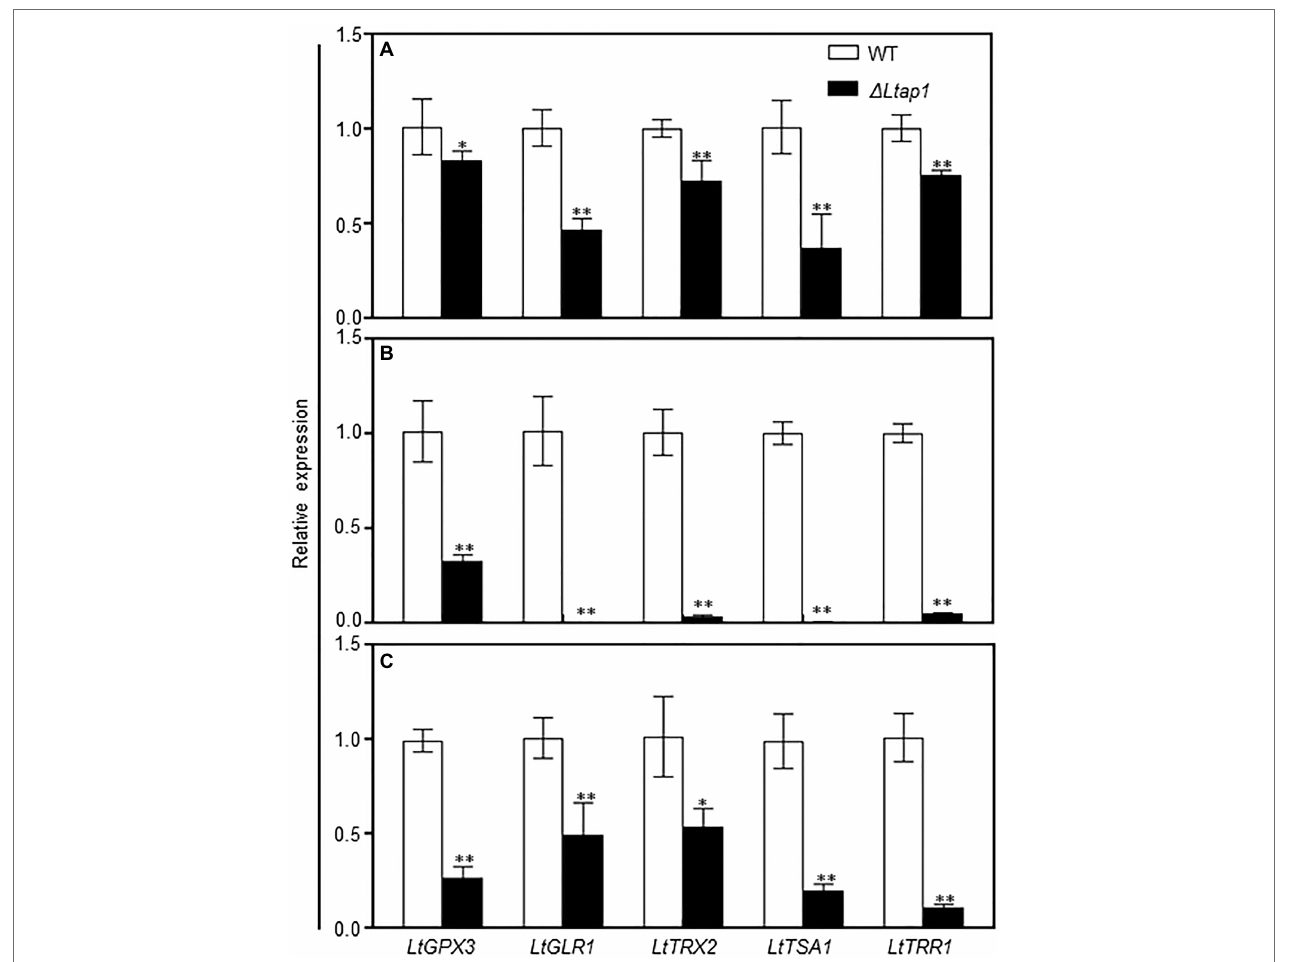
FIGURE 8 | qRT-PCR analysis of the glutaredoxin and thioredoxin systems genes in the WT, LtAP1 deletion mutant under H 2 O 2 treatment and in infected peach shoots. Mycelial samples of WT and the deletion mutant Δ Ltap1 treated with water (A) and 2.5 mm H 2 O 2 (B) were collected after 1 h culture at 28 ° C in darkness. (C) RNA samples were collected from the border of L. theobromae- colonized peach shoots at 5 dpi. The transcript levels were normalized with LtTUB and are displayed in relation to the transcript levels in the corresponding WT samples (which was therefore set to one). The values are means ± SD of three biological replicates. Asterisks indicate significant differences for genes between two genotypes, with * p < 0.01 and ** p <